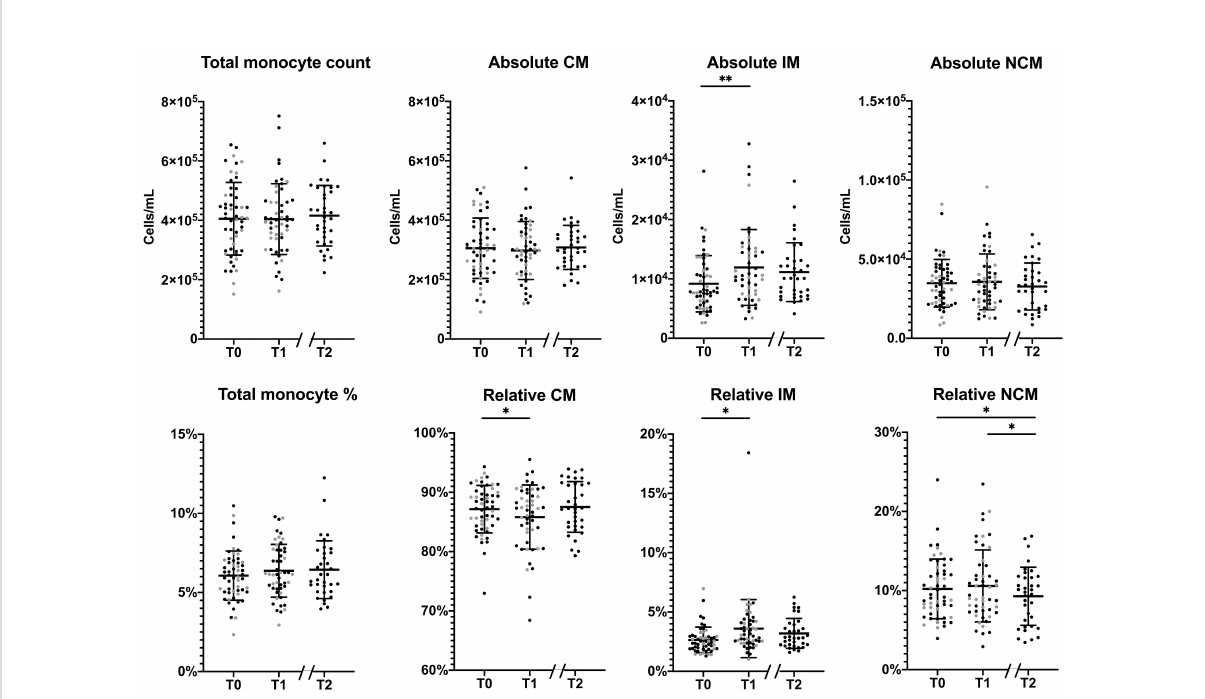
FIGURE 1 Changes in the monocyte subset distribution during the lifestyle intervention. Changes in absolute (upper row) and relative (lower row) monocyte levels in total monocytes, classical monocytes (CM), intermediate monocytes (IM) and non-classical monocytes (NCM) between T0 and T1 of patients who had a complete follow-up at T1 (n=51) and between T0 and T2 patients who completed the program (n=35). Individuals who had follow-up until T1 are represented as grey dots, individuals with follow-up until T2 are represented as black dots. Normally distributed data, (total monocyte counts, absolute CM/NCM and relative CM/NCM), are presented as mean ± SD. Non-normally distributed data, (absolute and relative IM), are presented as median and range. Paired T-tests were used to determine the differences between T0 and T1, and between T0 and T2 for normally distributed data, the Wilcoxon signed ranks test for non-normally distributed data. *p < 0.05, **p <